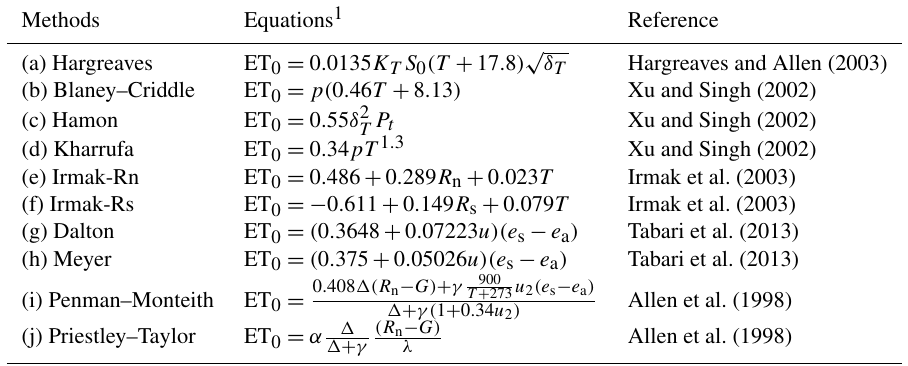
Table 1. Description of reference evapotranspiration estimation methods used in this study (ET 0 : reference